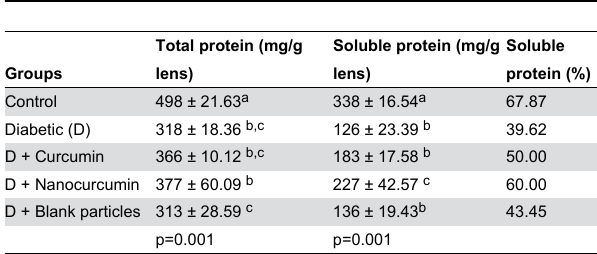
Table 3. The effect of curcumin and nanocurcumin on protein content of rat